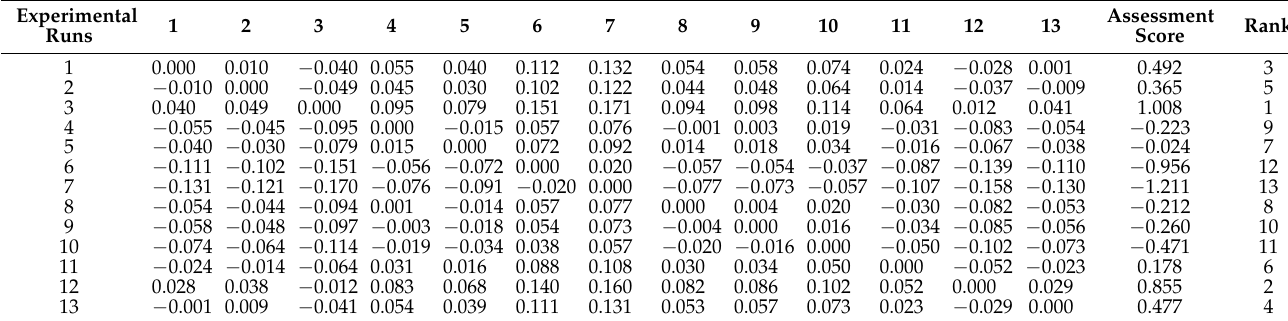
Table 10. Relative assessment matrix with assessment score and rank.